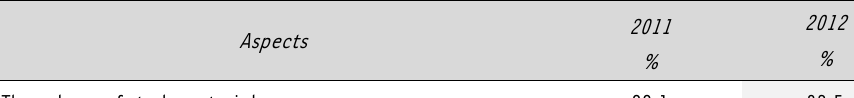
TABLE 1: Different aspects that impact on students